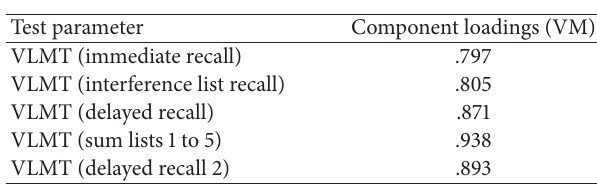
Table 3: (a) Component matrix of principal component analysis for VLMT parameters (1-factor solution). (b) Pattern matrix of main principal component analysis for cognitive domains. (4- factor solution). (c) Component intercorrelation matrix of cognitive domains. (d) Sample deviation of available cognitive variables in relation to expected values of a control population (percentile ranks and standard deviation).